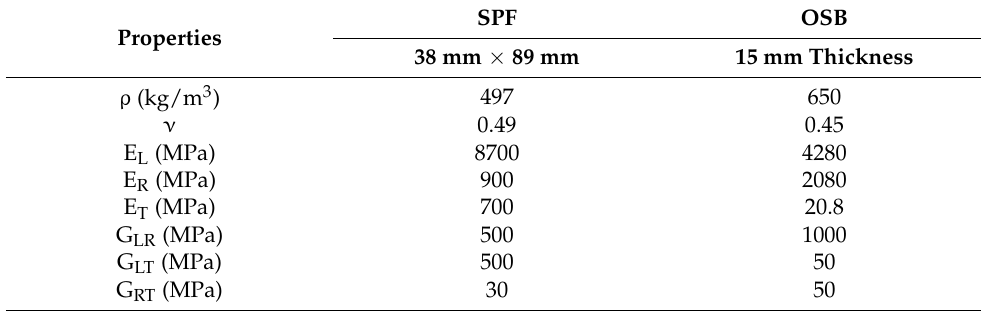
Table 2. Parameters of the engineered wood materials.